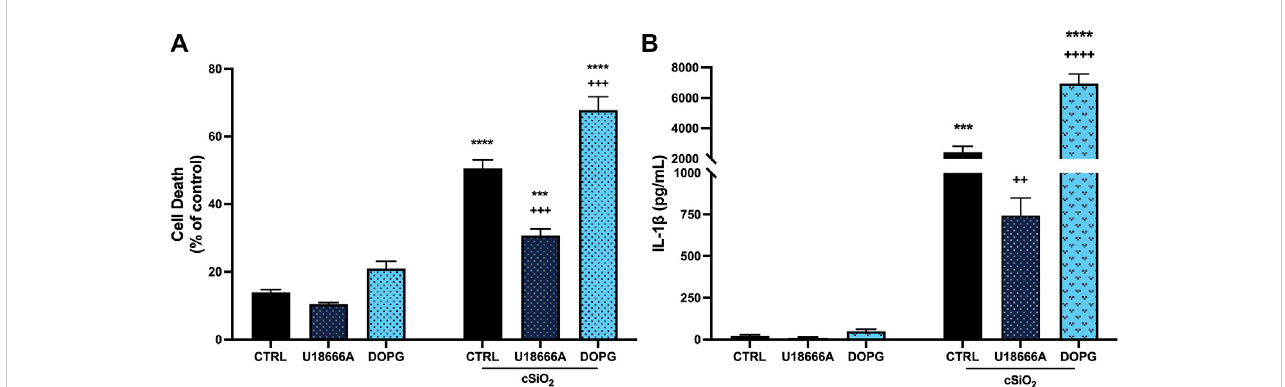
FIGURE 1 DOPG increased silica cytotoxicity and IL-1 β release in BMdM with U18666A producing an opposite effect. LPS-primed BMdM were treated with and without U18666A (10 μ g/mL) or DOPG (50 μ M) for 1 h prior to silica (50 μ g/mL) application in complete media. After 24 h, (A) cell death was assessed as LDH releaseinsupernatantsand (B) IL-1 β releasewasmeasuredbyELISA.Dataexpressedas mean ± SEM , n =4Analyzedbytwo-wayANOVAwithTukey'smultiple comparisons test. * p < 0.05, ** p < 0.01, and **** p < 0.0001 compared to control untreated cells. ++ p < 0.01 and +++ p < 0.001 compared to silica- exposed